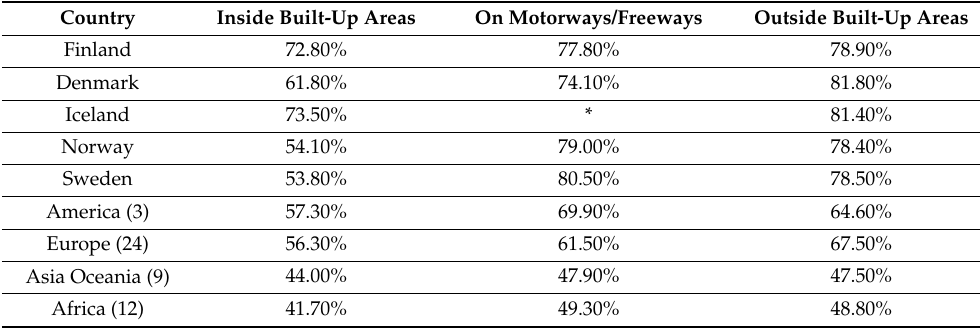
Table 2. Proportion of drivers who exceeded the speed limit while driving in the past 30 days. Country Inside Built-Up Areas On Motorways/Freeways Outside Built-Up